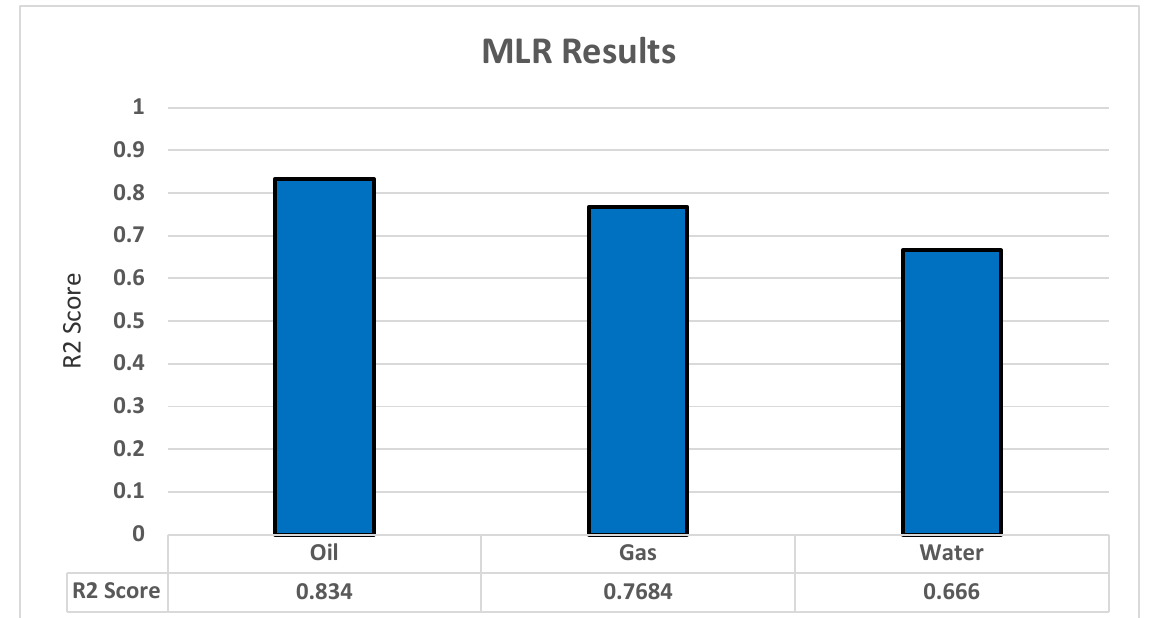
MLR: Comparison of R2 scores for oil, gas, and water Figure 4. MLR’s R2 score results.